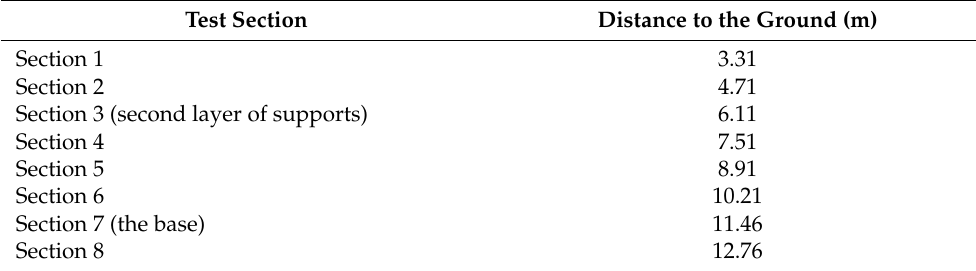
Figure 1. Test section layout. Table 1. Position of test section.